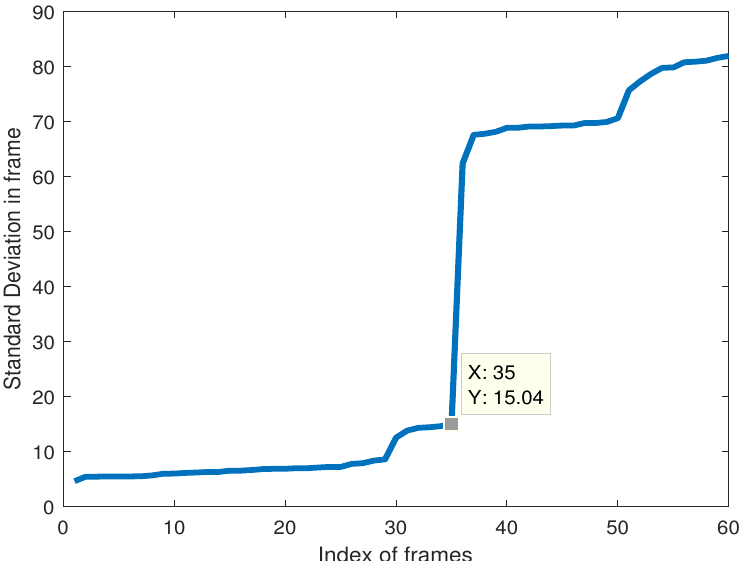
Figure 4. Coordinate standard deviation in a configuration involving 5 prongs within a 40-degree cone from the